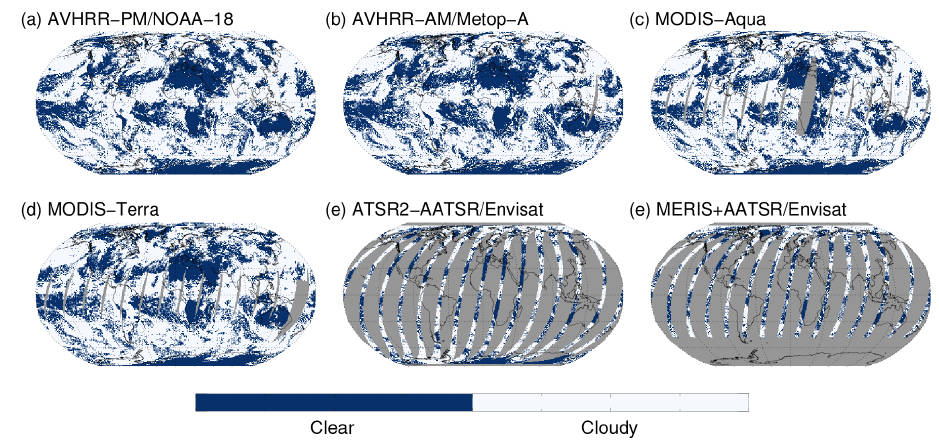
Figure 2. Daily Level-3U cloud mask composites for 22 June 2008 demonstrating the spatial coverage of the daytime nodes of selected sensors within 24h. See Table 3 for definition of